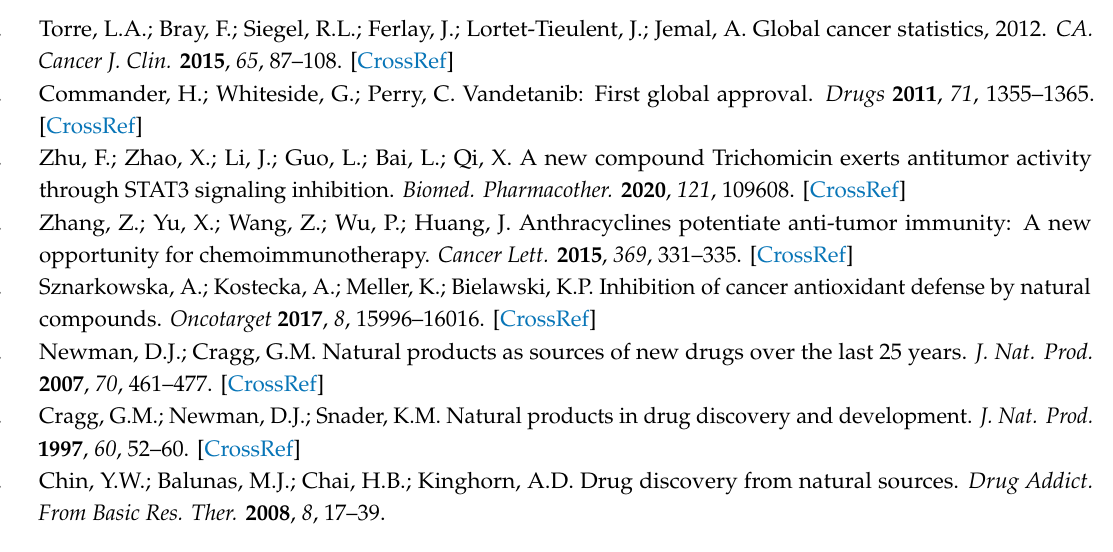
S18: The ESI-MS spectrum of compound 4 ; Figure S19: 1 H NMR (400 MHz) spectrum of compound 5 in CDCl 3 ; Figure S20: The ESI-MS spectrum of compound 5 ; Figure S21: 1 H NMR (400 MHz) spectrum of compound 6 in CDCl 3 ; Figure S22: The ESI-MS spectrum of compound 6 ; Figure S23: 1 H NMR (400 MHz) spectrum of compound 7 in CDCl 3 ; Figure S24: ESI-MS spectrum of compound of compound 7 ; Figure S25: 1 H NMR (400 MHz) spectrum of compound 8 in CDCl 3 ; Figure S26: 13 C NMR (150 MHz) spectrum of compound 8 in CDCl 3 ; Figure S27: The HRESIMS spectrum of compound 8